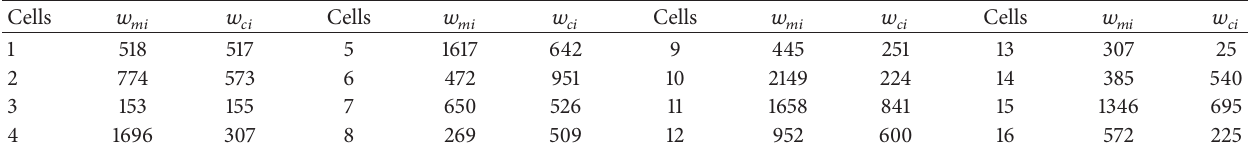
Table 1: Cells attribute for the 4 × 4 test network.